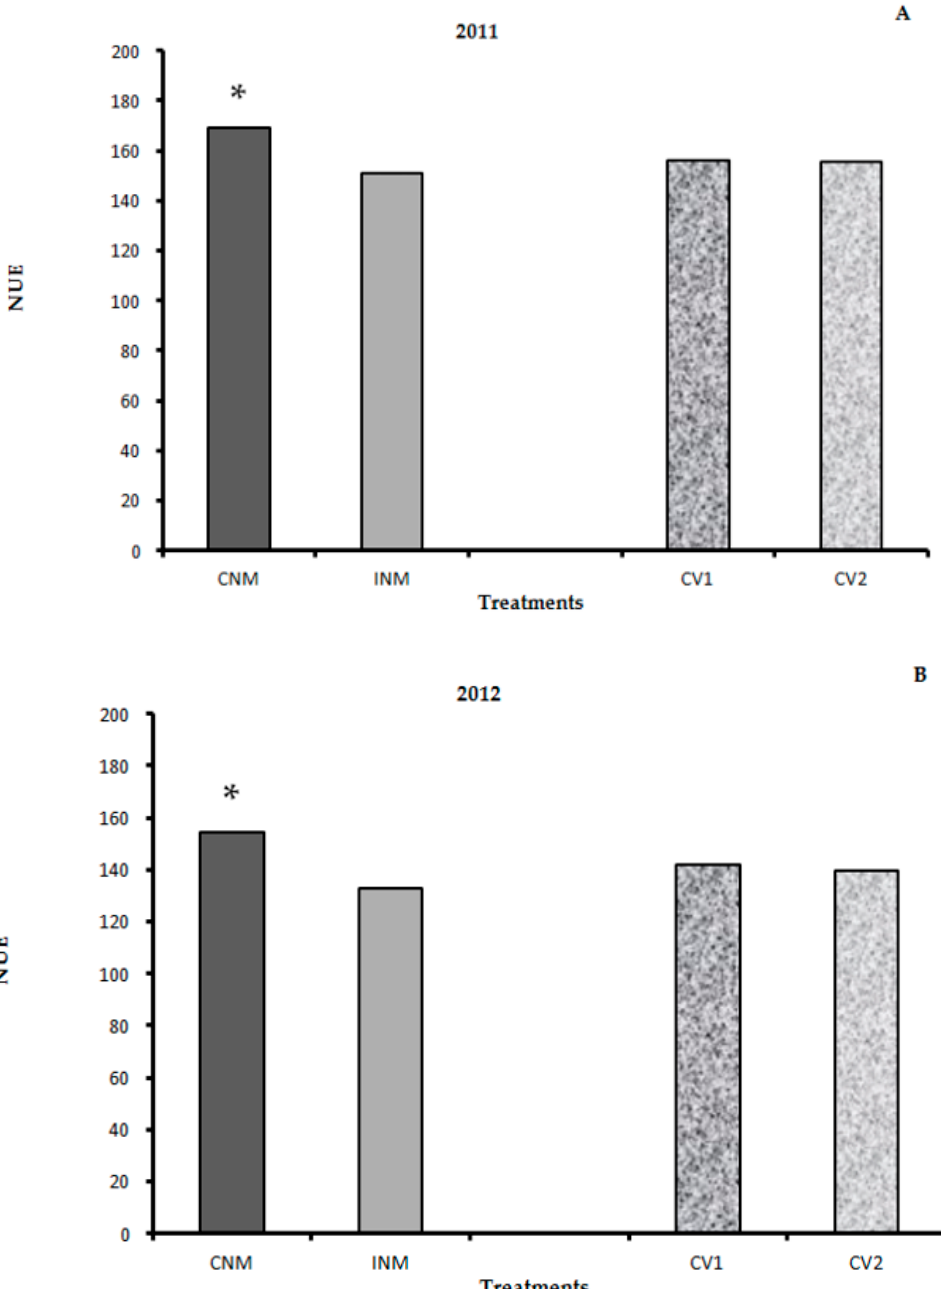
Figure 1. Main e ff ects of nutrient management and cultivar on N utilization e ffi ciency (NUE) in first (A) and second (B) year in chrysanthemum plants at harvest time (* indicates the level of significance at p <